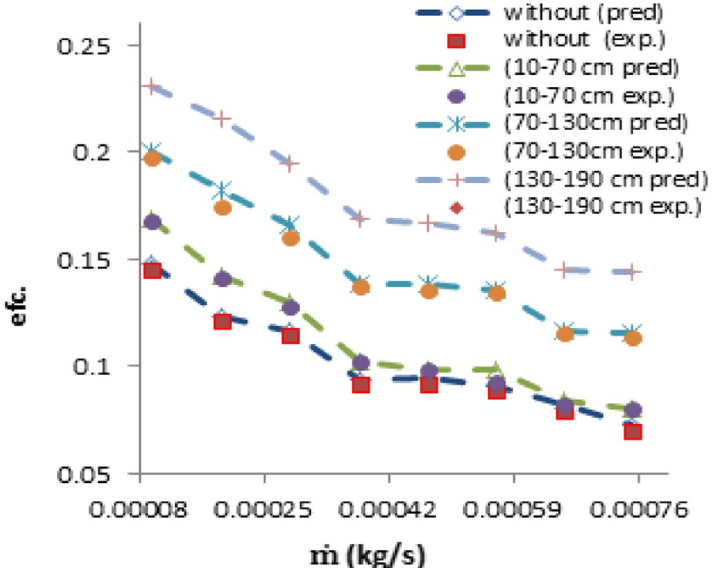
Fig. 13 ANN predicted and experimental heat exchanger effectiveness with and without